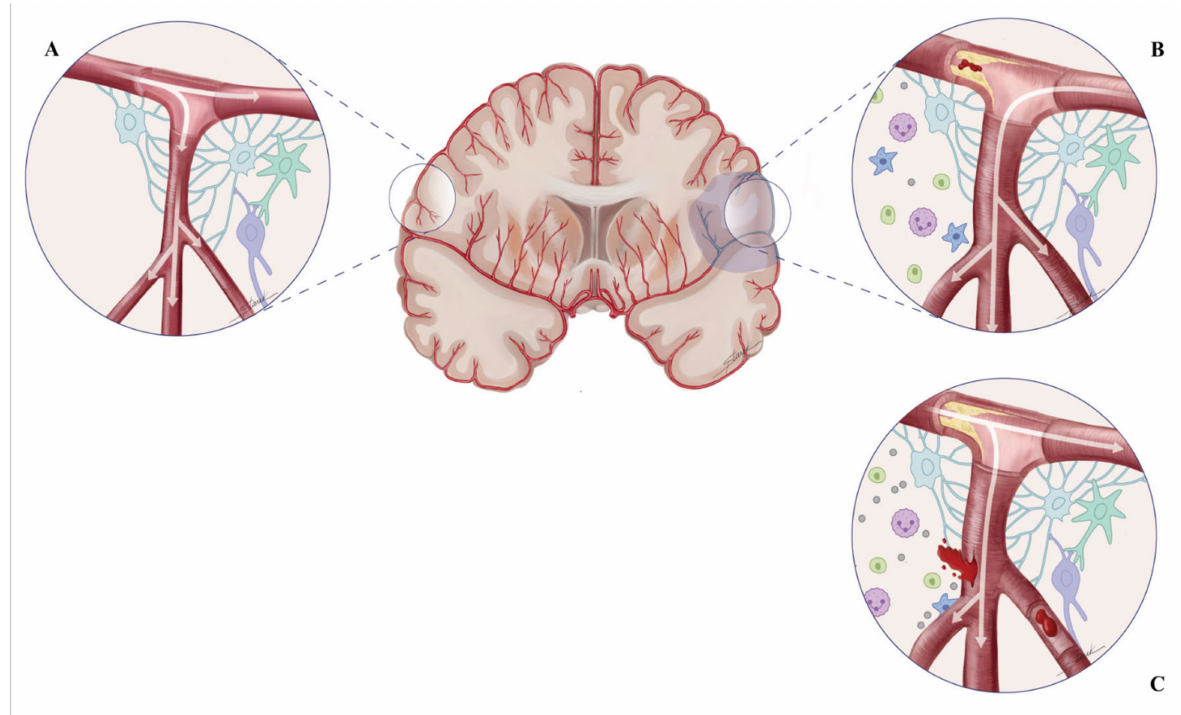
Figure 1. ( A ) Schematic representation of pial artery with penetrating vessel (intracerebral arteries) and its intraparenchymal components. ( B ) After vessel occlusion there is a vasodilatory response with flow diversion and inflammatory process in the ischemic area. ( C ) Perpetuation of ischemic process increases inflammatory response; at this time if the vessel is reperfused, ischemic lesions (ex. hemorrhage) and/or distal occlusion may result in futile